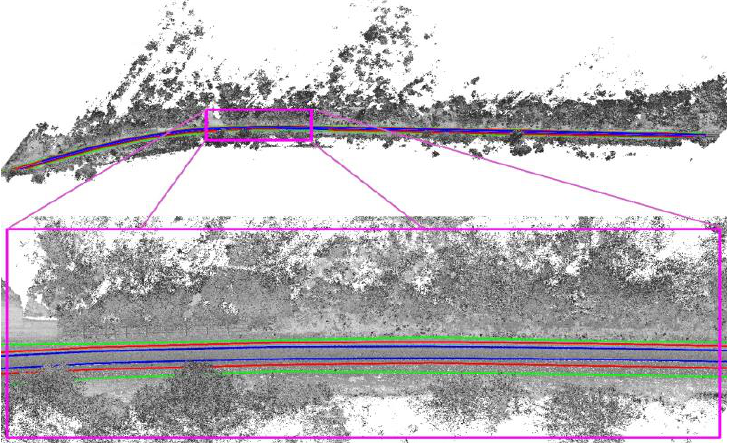
Infrastructures 2019 , 4 , x FOR PEER REVIEW Figure 14. Highlighted area of total line’s extraction. Figure 14. Highlighted area of total line’s extraction. Figure 14. Highlighted area of total line’s extraction.